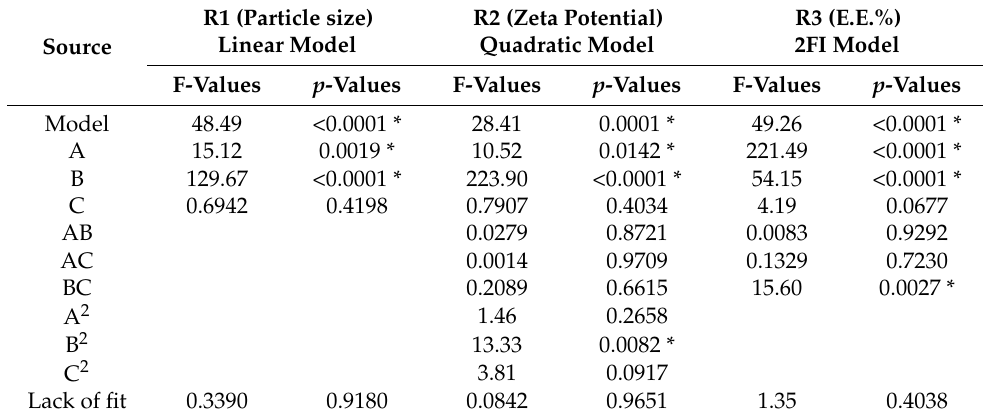
Table 4. Coefficients of different formulation variables according to the model of best